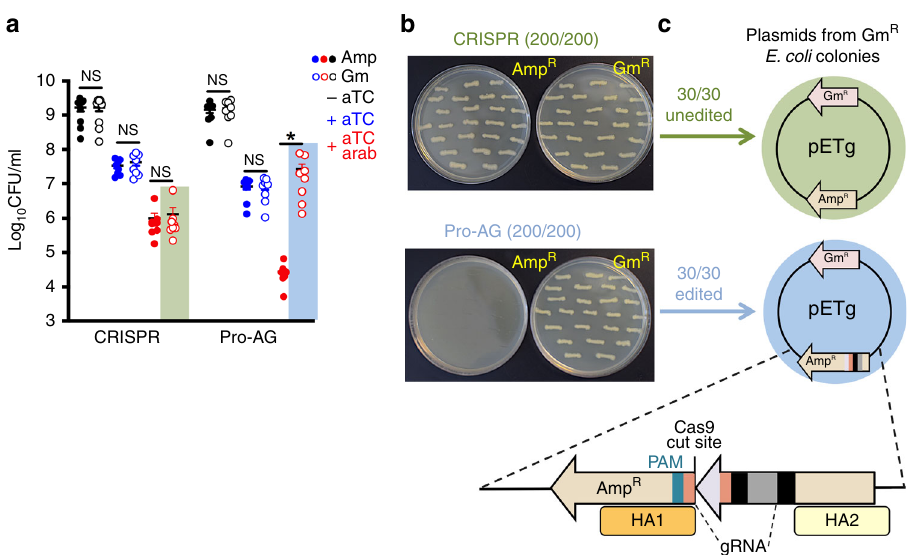
Fig. 2 Ef fi cient reduction of Amp R CFU by Pro-AG results from homology-mediated insertion of active gRNA cassettes into the bla target gene. a Selection for E. coli CFU on ampicillin (Amp, fi lled dots) or gentamicin (Gm, open dots) plates following CRISPR-control- or Pro-AG-mediated targeting of the dual antibiotic-resistant target plasmid pETg (see pETg plasmid schematic in c from single colonies grown in the presence ( + aTc, blue dots), in the absence ( − aTc, black dots) of anhydrotetracycline for induction of Cas9, or in combination of aTc and arabinose ( + aTc + arab, red dots) for induction of Cas9 and λ Red, respectively. b Individual colonies isolated from gentamicin plates following Cas9 and λ Red induction under CRISPR (green shaded box) or Pro-AG (blue shaded box) regimens in a were streaked on new ampicillin (Amp R , left images) and gentamicin (Gm R , right images) plates. Representative images of 200 colonies struck from CRISPR-control (top) or Pro-AG (bottom) are shown. c DNA sequence analysis of plasmids isolated from single colonies in b recovered from either the CRISPR-control regimen (Amp R or Gm R plates; green arrow) or the Pro-AG regimen (Gm R plates; blue arrow). All 30 CRISPR-derivative clones analyzed revealed a fully intact pETg plasmid (unedited, green circle), whereas all 30 Pro-AG-derivative clones analyzed carried a perfect insertion of the homology- fl anked gRNA2 expression cassette into the bla gene (zoom-in bottom scheme). The gRNA expression cassette is composed of the gRNA scaffold (purple), 20 bp gRNA-targeting sequences (pink and black), and the constitutive tet promoter (gray). Also indicated are the Cas9 cleavage site, and homology arms (HA1, dark yellow box and HA2, light yellow box) that fl ank the gRNA2 cleavage site in the bla target gene carried on the pETg plasmid. Data in a are plotted as the mean ± SEM, representing three independent experiments performed in triplicate and analyzed by Student ’ s t test. N.S . = not signi fi cant ( P > 0.05) * P < 0.05. Source Data are available in the Source Data fi